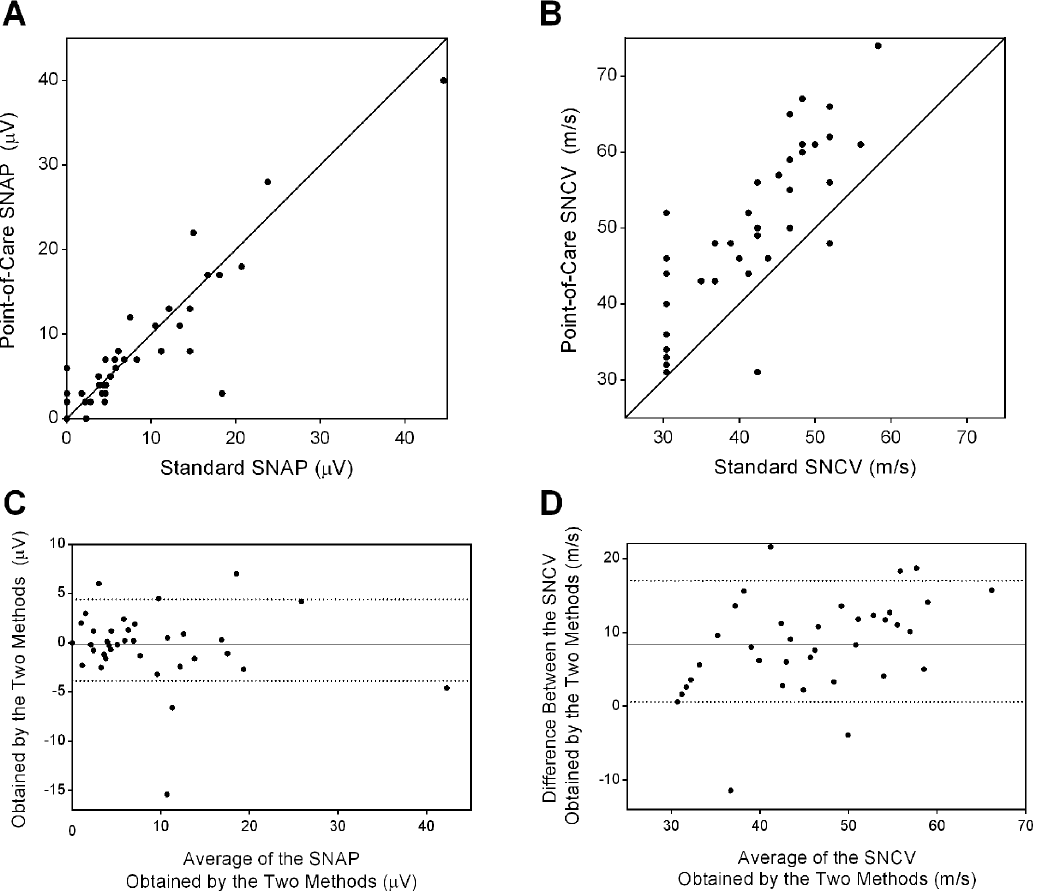
Figure 2. Scatterplots (A,B) and Bland-Altman plots (C,D) for comparison of the point-of-care nerve conduction method versus standard NCS for SNAP or SNCV. Panels A and B: Scatterplot of SNAP (A) and SNCV (B) showing the line of unity (diagonal solid line) between the two methods. Panels C and D: The Bland-Altman plots demonstrating the mean difference (depicted by the solid line) between SNAP (C) or SNCV (D) obtained by the two methods. Points above or below zero on the y-axis represent over- and underestimation by the point-of-care device, respectively. The dotted lines represent the upper and lower limits of the 85% confidence interval. Unrecordable SNCV results for both nerve conduction methods were assigned a value of 30.4 m/s, representing the lowest value in the dataset. Such data handling was applied to 9 values for standard NCS and 3 values for the point-of-care device.